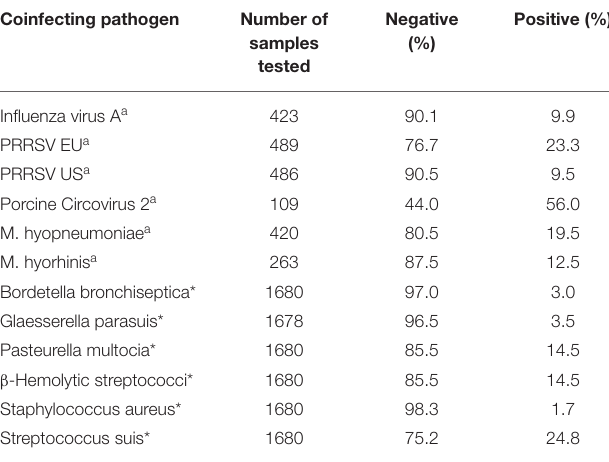
TABLE 4 | Coinfecting pathogens in the respiratory tract of pigs positive for APP